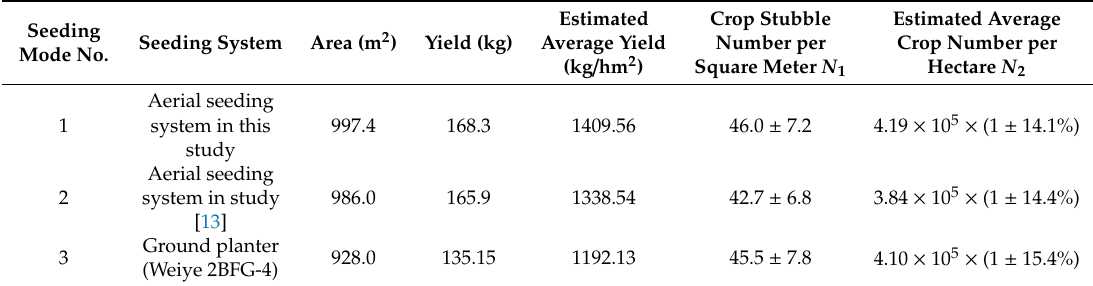
Table 4. Yield investigation and stubble counting